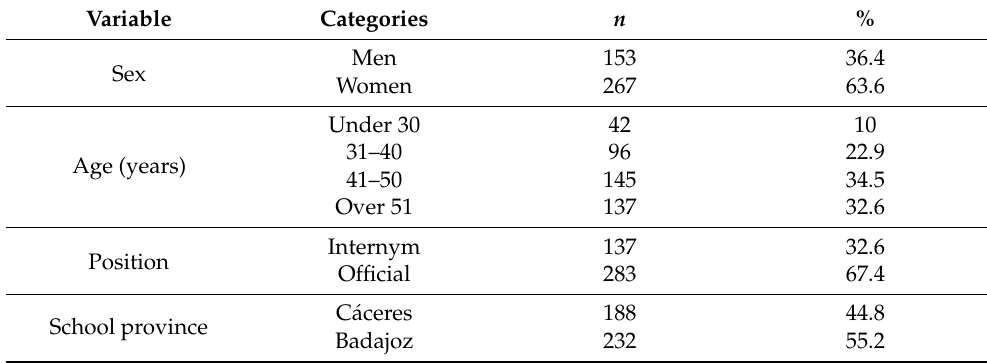
Table 1. Sample sociodemographic data ( n =